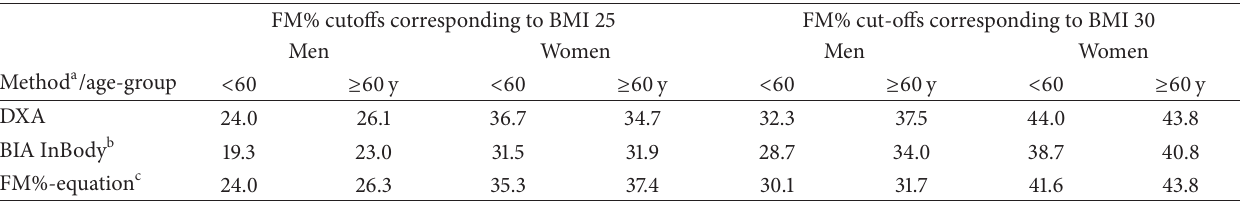
Table 3: Values in fat mass percentage (FM%) for the method-specific percentile corresponding to BMI percentiles at BMI 25 and 30,